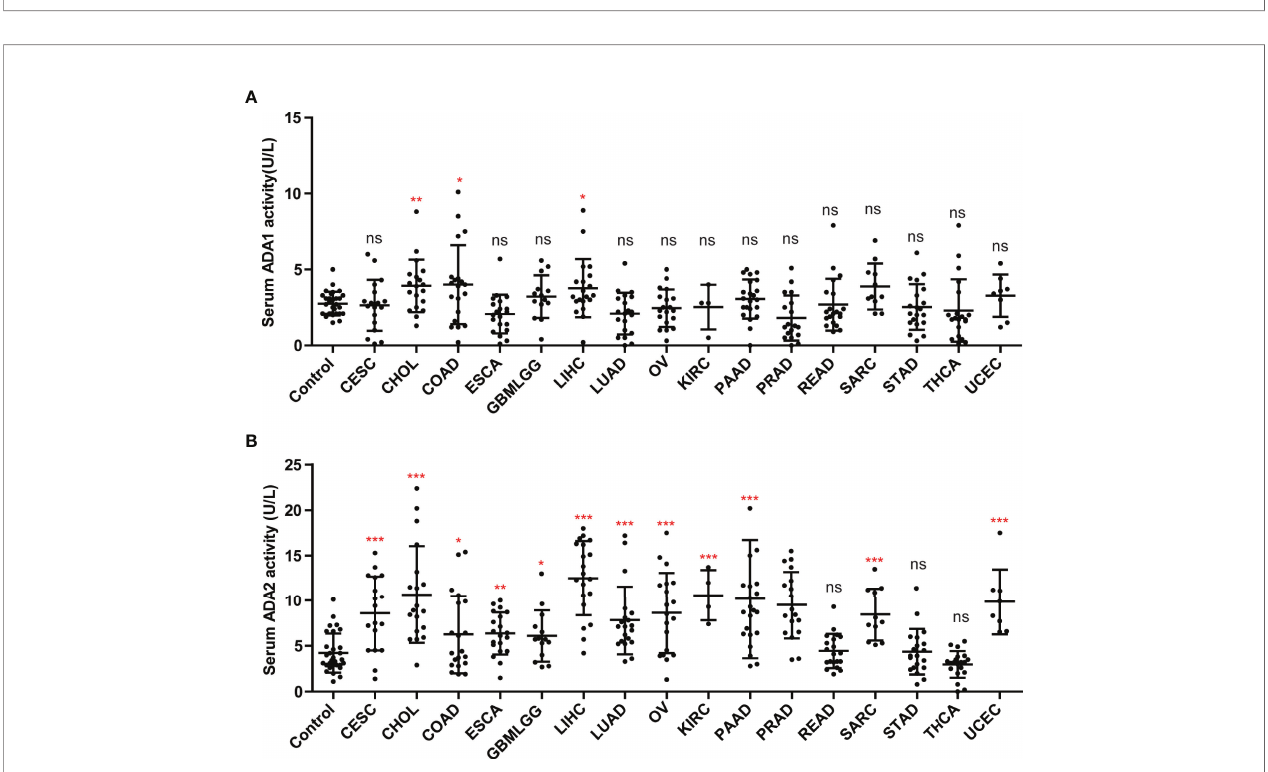
FIGURE 8 | The activities of ADA1 and ADA2 in serum from cancer patients. (A) Serum ADA1 activity in cancers. (B) Serum ADA2 activity in cancers. *p < 0.05, **p < 0.01, ***p < 0.001. ns, no signi fi